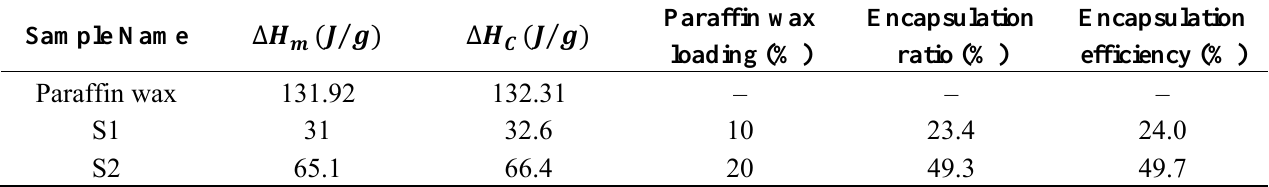
Table 3. The phase change behavior and performance of microencapsulated paraffin